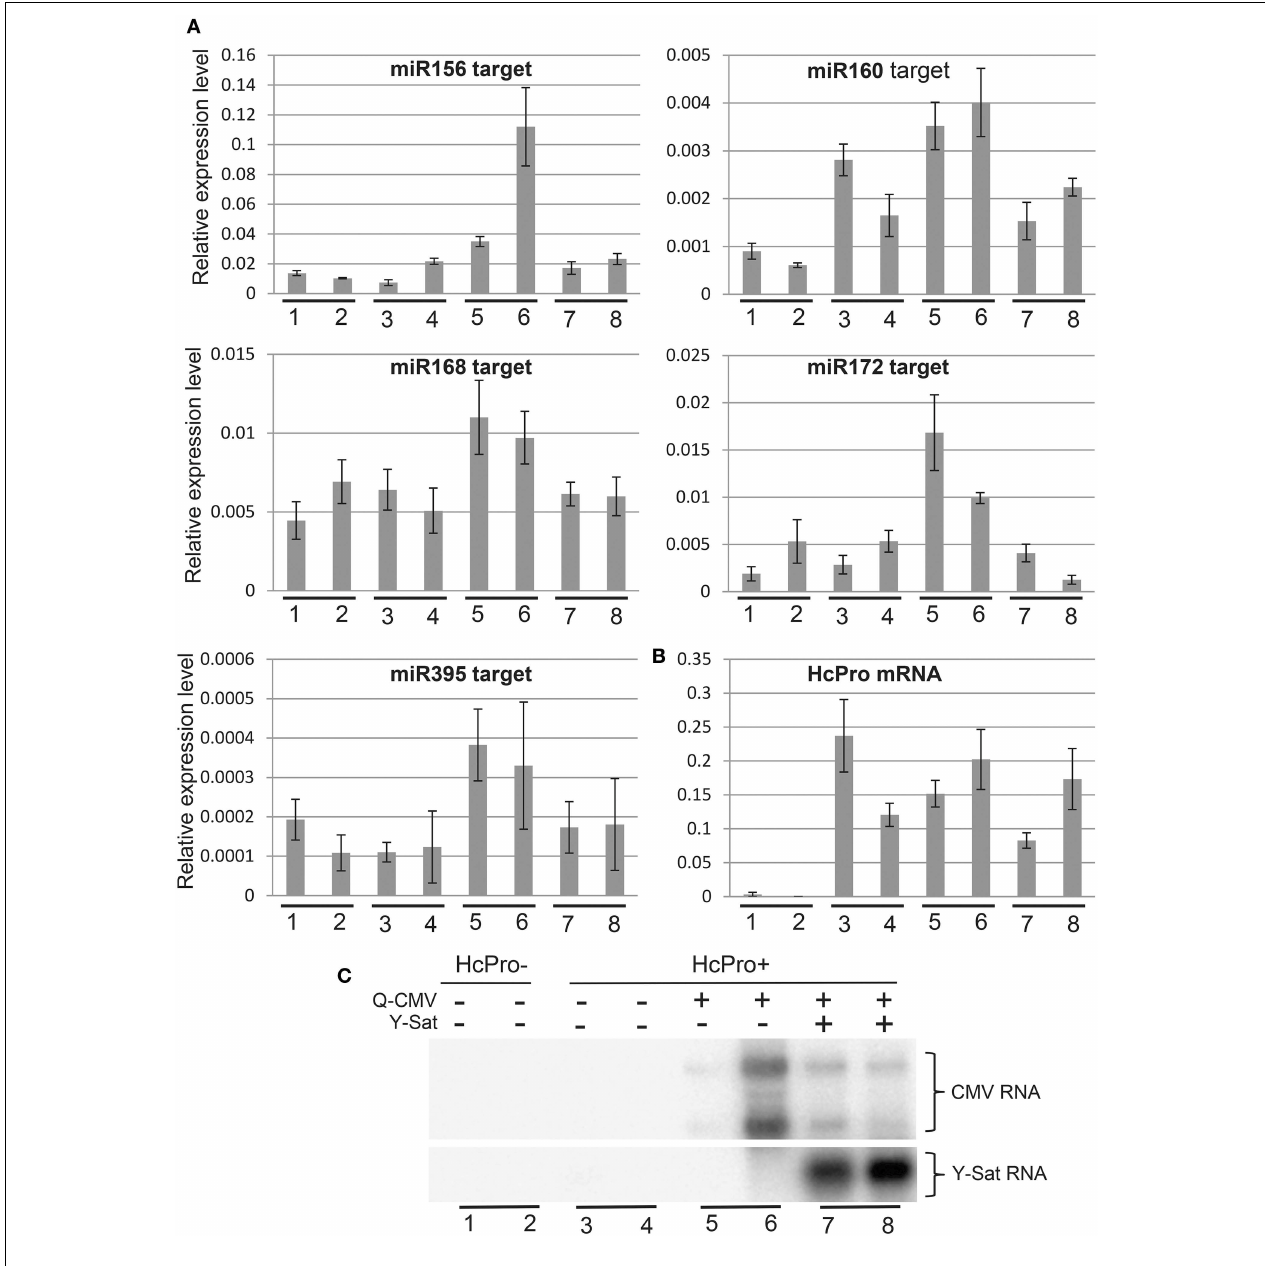
FIGURE 4 | The increased expression of miRNA target genes by CMV infection in HcPro-expressing N. tabacum plants is reversed in the presence Y-Sat. (A) qRT-PCR analysis of predicted target genes for miR156, miR160, miR168, miR172, and miR395. The EF1 α gene was used as the internal reference. (B) qRT-PCR analysis of